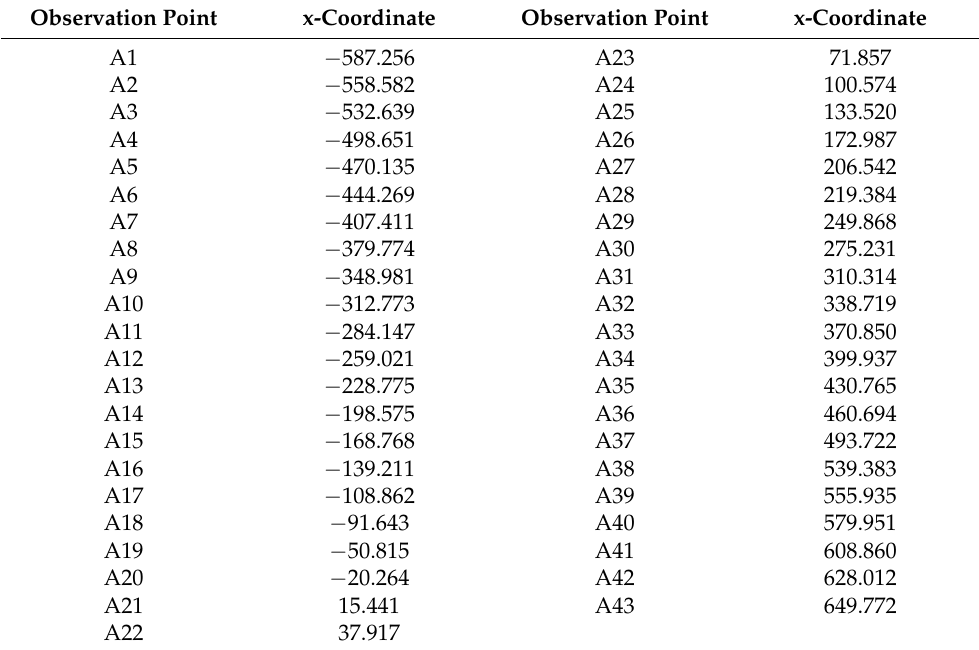
Table 3. The x-coordinates of the observation points along the strike section